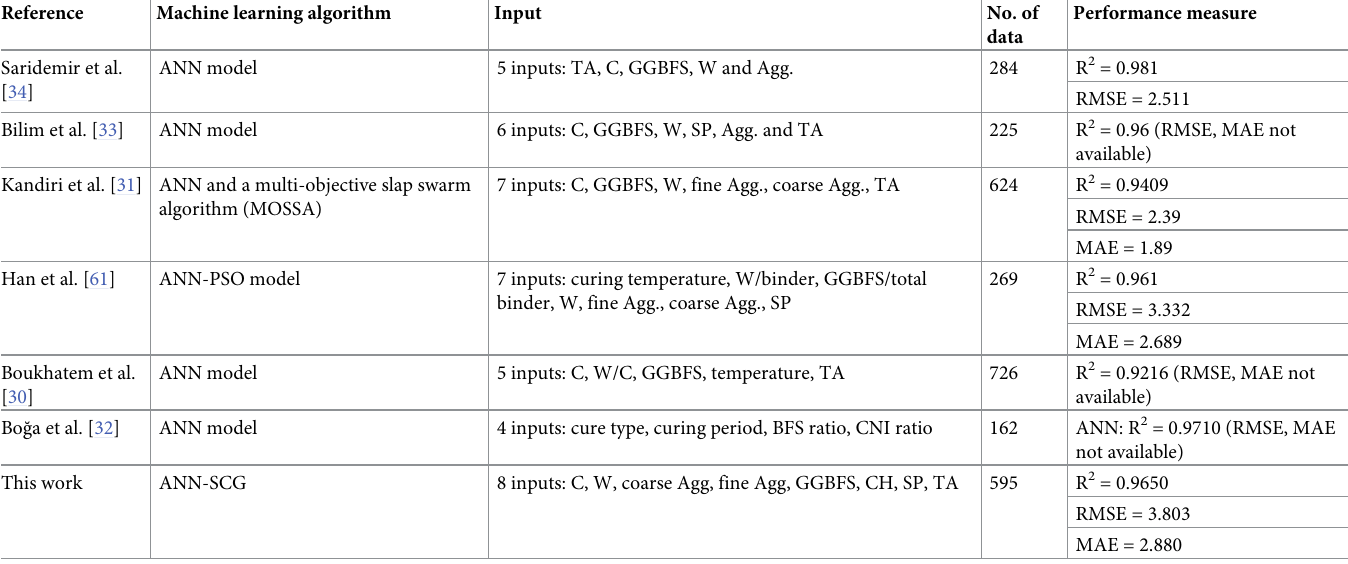
Table 5. Comparison of different machine learning models for predicting compressive strength of concrete containing